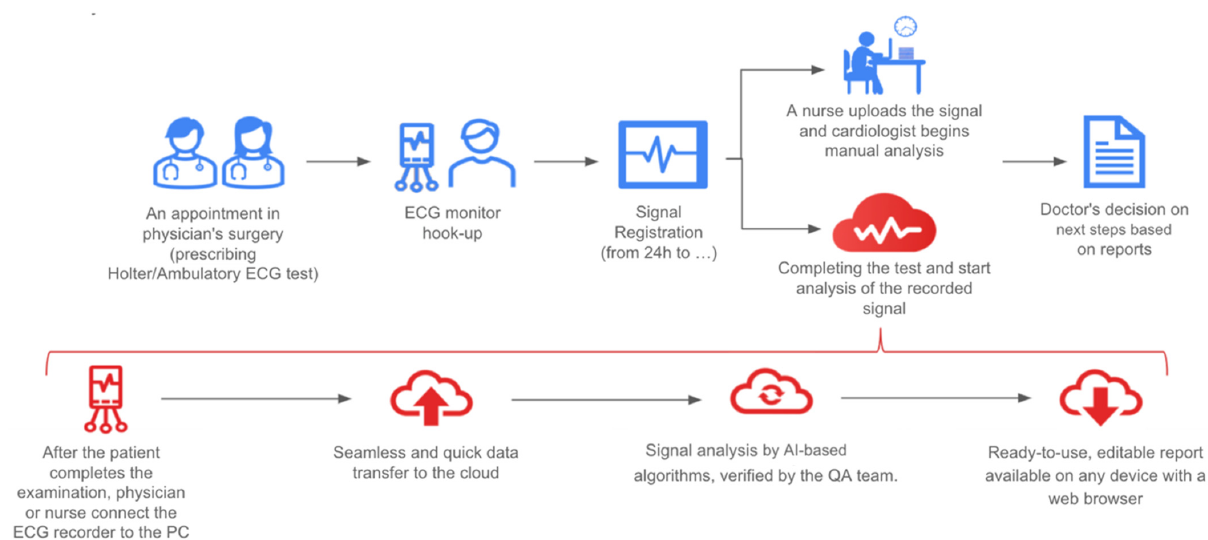
Figure 4. A potential workflow for AI use in everyday practice.